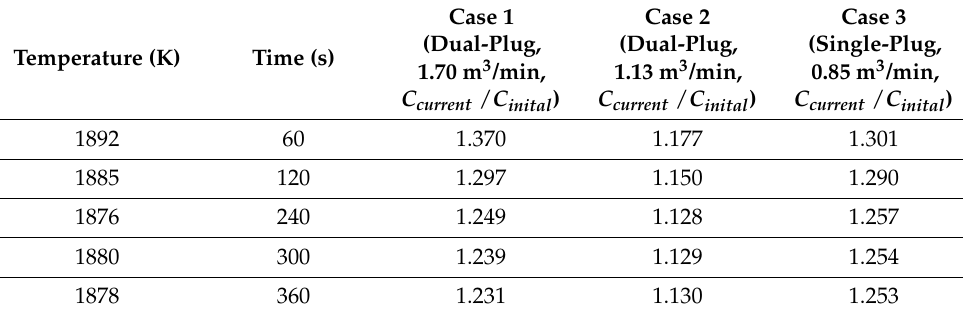
Figure 15. Mixing behavior of copper for 0.85 m 3 /min total flow rate. Table 4. Scaled recovered copper concentrations on parametric